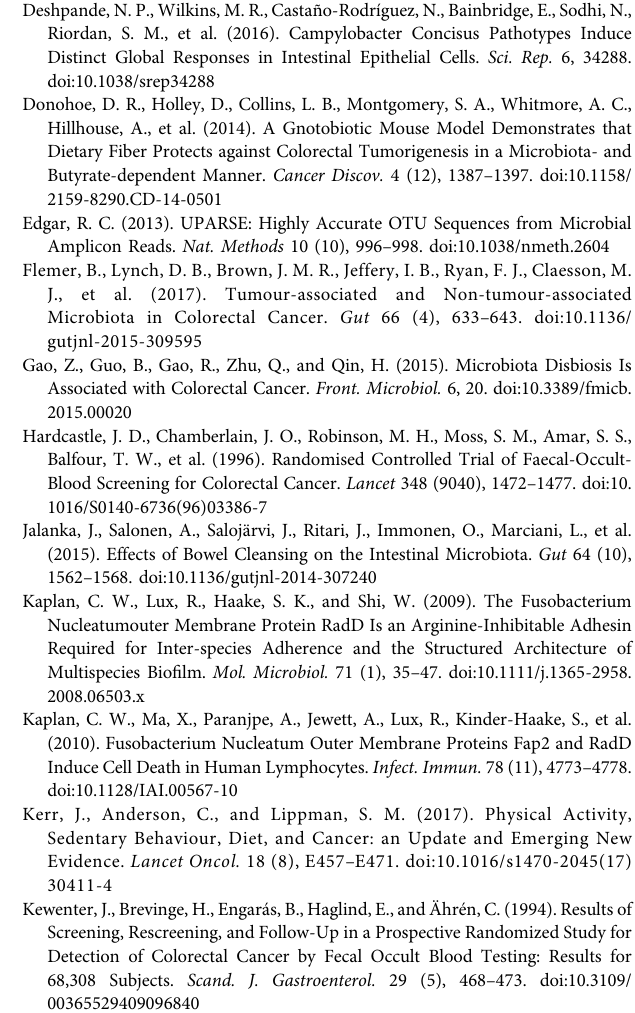
Supplementary Figure 1 | Comparison of dietary intake including energy, protein, fat, carbohydrate, and fi ber intake between the FOBT positive and FOBT negative patients. Supplementary Figure 2 | Comparison of α diversity indexes and relative abundance (%) of microbiota at phylum level between the FOBT positive and FOBT negative groups at tumor mucosa (T), para-cancerous mucosa (P), normal mucosa (N), and feces (F) sites. (A) Comparison of α diversity indexes (ACE, Chao1, Shannon, and Simpson) between the FOBT positive and FOBT negative groups at different sampling sites. (B) Relative abundance (%) of phyla in the FOBT positive and FOBT negative groups at different sampling